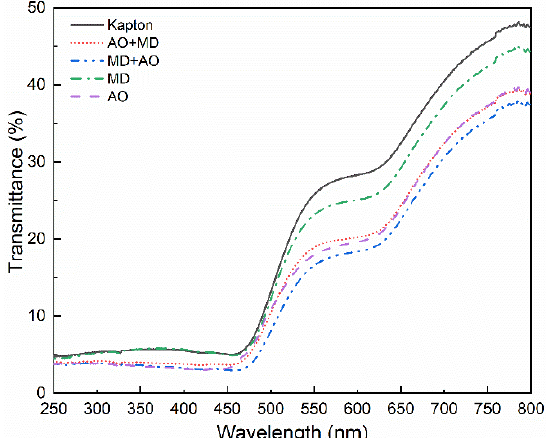
Figure 5. Optical transmittance of Kapton film before and after different load spectrum tests.